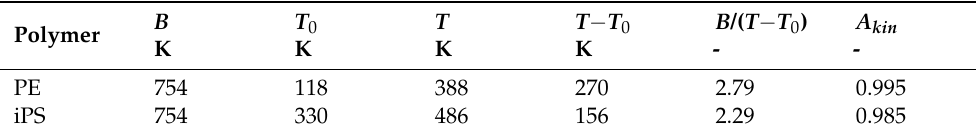
Table 5. Relative change in the nucleation rate due to a change in the kinetic barrier in PE and iPS at δ T = − 0.5 K.